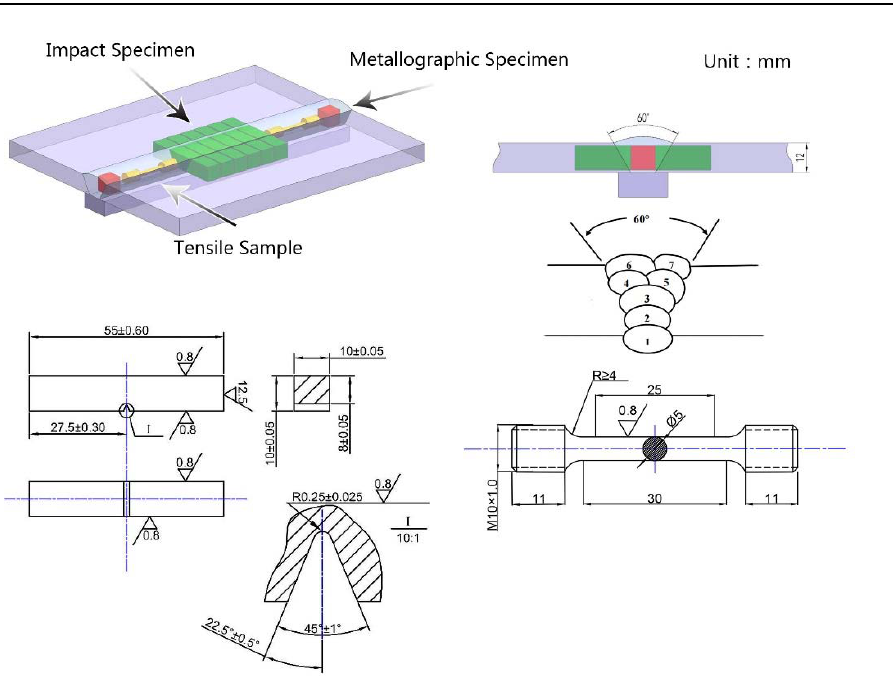
Figure 2. Welding diagram and sampling diagram.